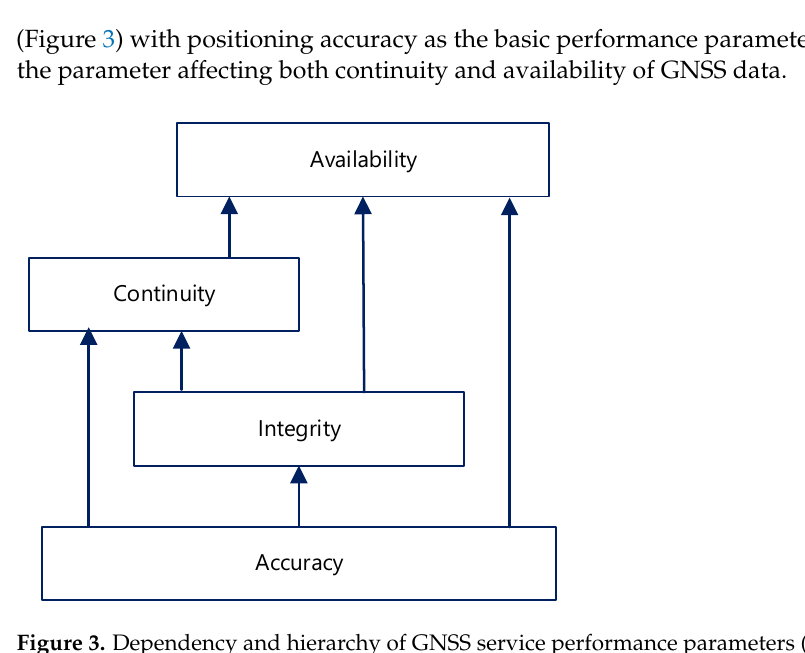
6 of 28 Figure 2. Horizontal protection level (HPL) and alert limit (HAL) (based on [19]). Concluding, the resolution A.915(22) has given grounds for the application of GNSS integrity concept in the maritime domain. Its definition of reliability of position fix is